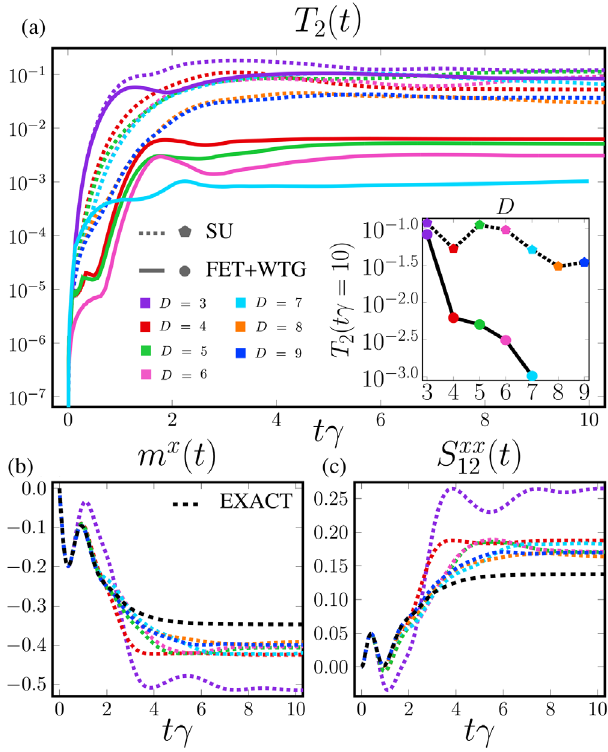
FIG. 5. Comparison between FET þ WTG (solid lines), SU (dotted lines), and EXACT (dashed lines) in the moderately damped regime of the dissipative Ising model V= γ ¼ 1 . 2 , h x = γ ¼ 0 . 0 . (a) Trace distance T 2 ð t Þ as a function of time and at t γ ¼ 10 (inset) for a range of bond dimensions. (b) Magneti- zation m x ð t Þ and (c) nearest-neighbor S xx 12 , showing that FET þ WTG outperforms